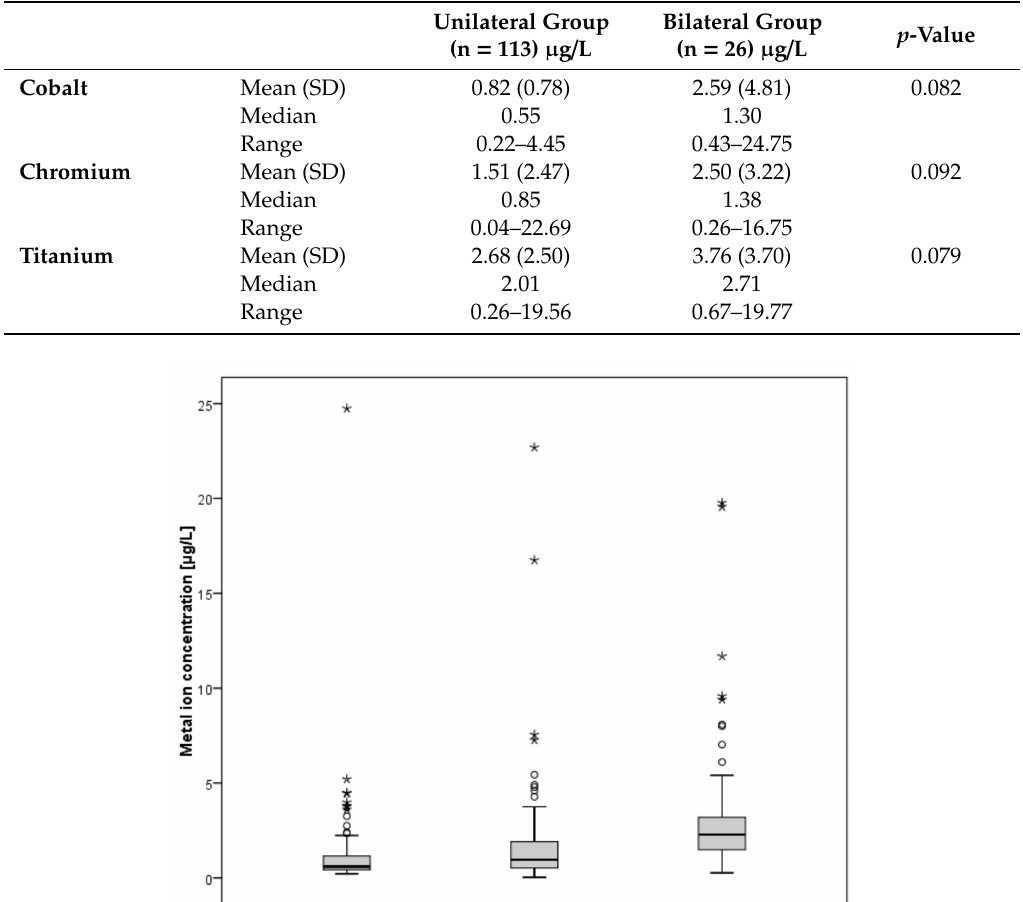
Table 2. Results of blood metal ion analysis.